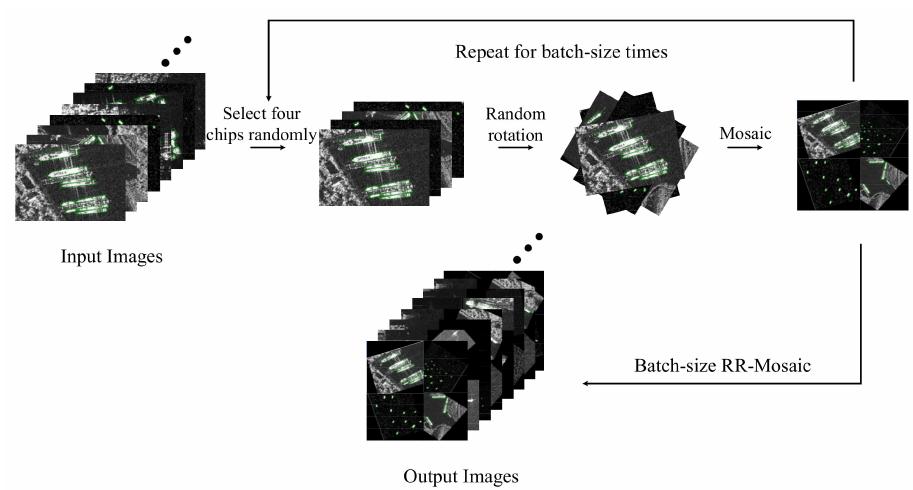
Figure 3. Random rotation mosaic (RR-Mosaic) data